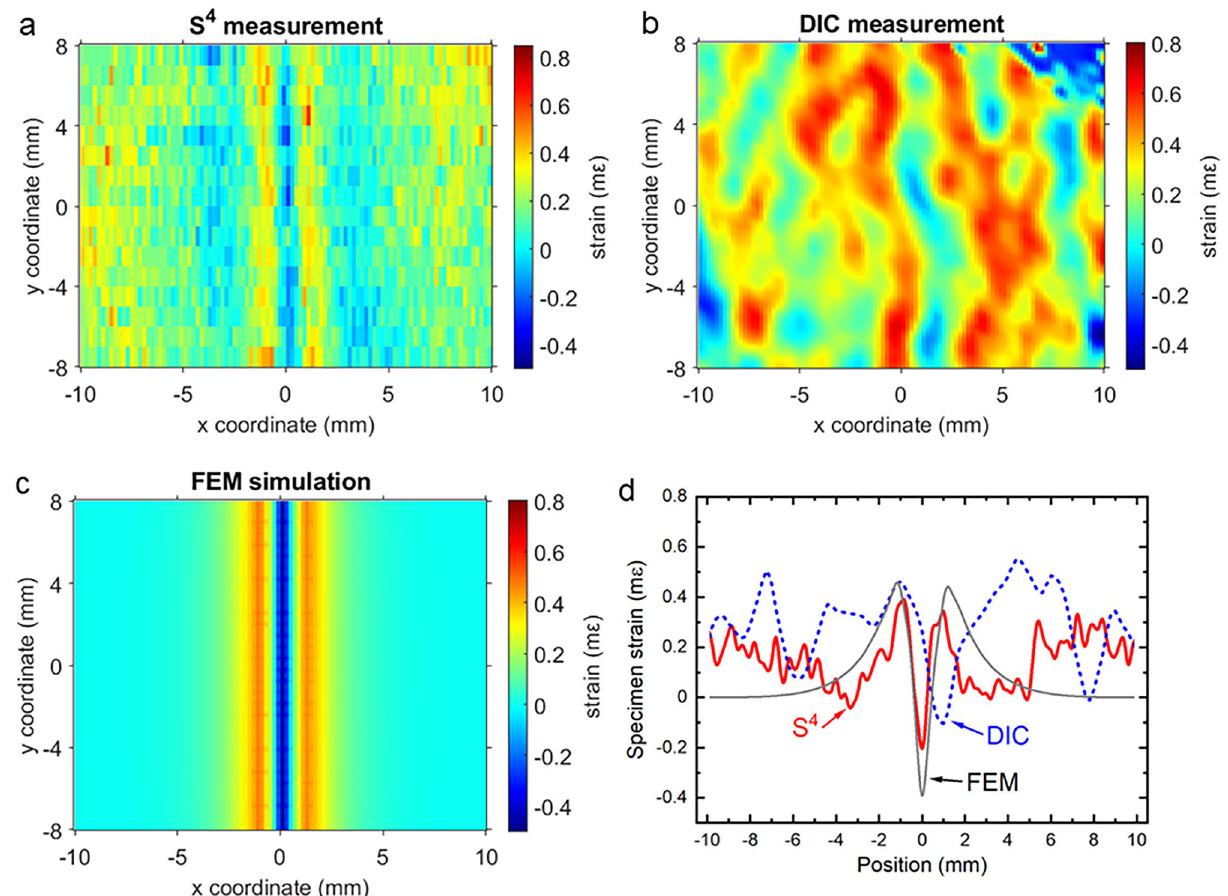
Figure 7. Color-coded strain maps of the subsurface drilled and stressed aluminum specimen as found from ( a ) S 4 measurements; ( b ) DIC measurements; ( c ) FEM simulation. Frame ( d ) shows strain profiles from the three methods along the x direction at y =